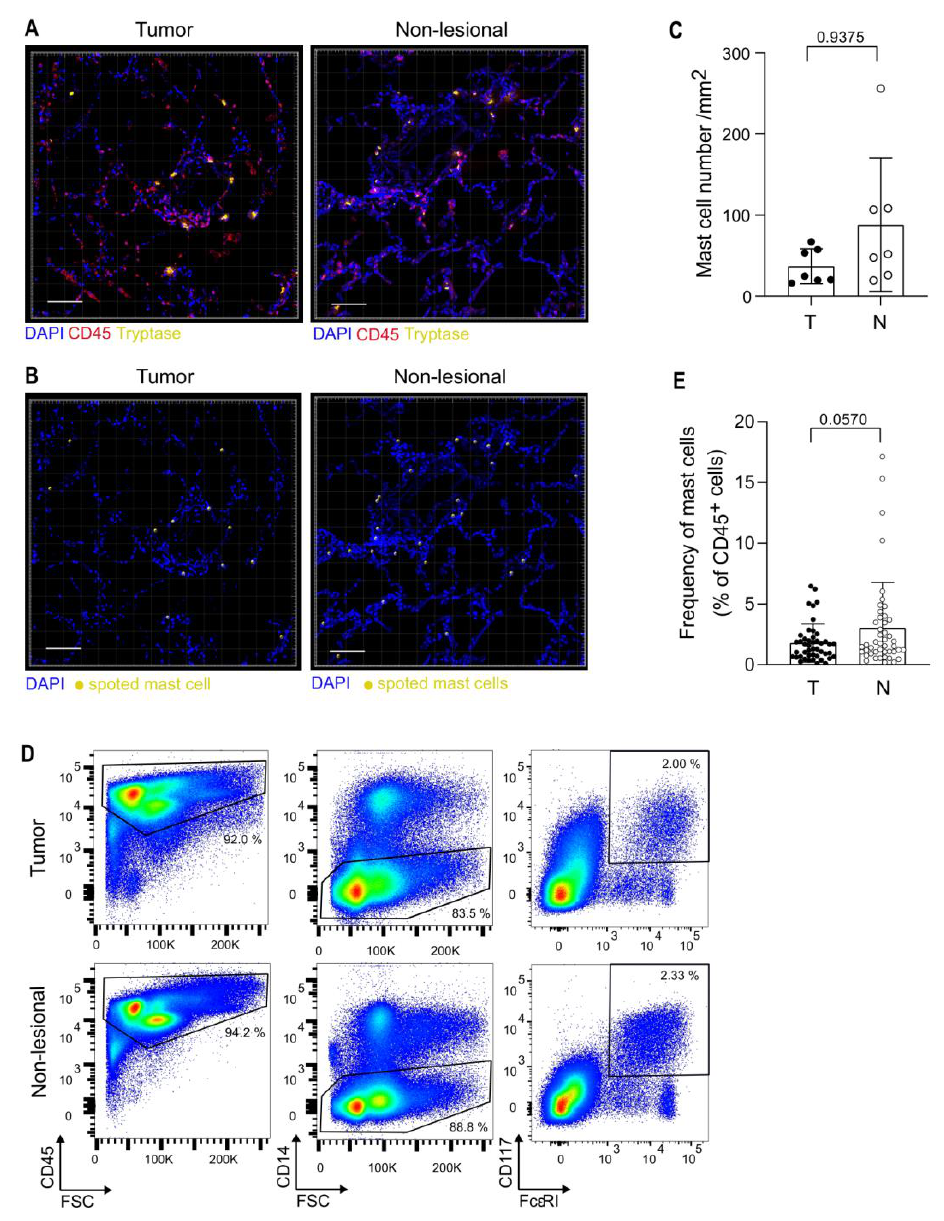
Figure 1. Mast cells are relatively abundant within the tumor microenvironment of NSCLC patients. ( A ) Representative confocal images of tumoral and non-lesional lung tissue sections stained for Tryptase (Yellow), CD45 (red), and DAPI (blue). Scale bar, 100 µm. ( B ) Tryptase + mast cells (yellow) were identified and quantified using Imaris software. Each dot represents one cell. Scale bar, 100 µm. ( C ) MC number in tumoral (T) and non-lesional (N) matched tissues ( n = 7 NSCLC patients). ( D ) MC gating strategy. Representative dot-plots showing CD117 + FcεRI + MCs gated on CD45 + CD14 − cells isolated from tumoral and non-lesional lung tissues. ( E ) Frequency of CD117 + FcεRI + MCs among single, live, CD45 + cells in tumoral (T) and non-lesional (N) lung tissues in 46 NSCLC patients. ( C , E ) Mean and SD are shown, Wilcoxon paired t-test, p -values are indicated. To get insights into tumor-associated MC (TAMC) location in relation to tumoral cells, we next analyzed tryptase + cells and cytokeratin + cell (tumoral cells) distribution pattern in the TME by confocal microscopy (Figure 2A). We first noticed that TAMCs globally followed the same distribution pattern as the CD45 + immune infiltrate